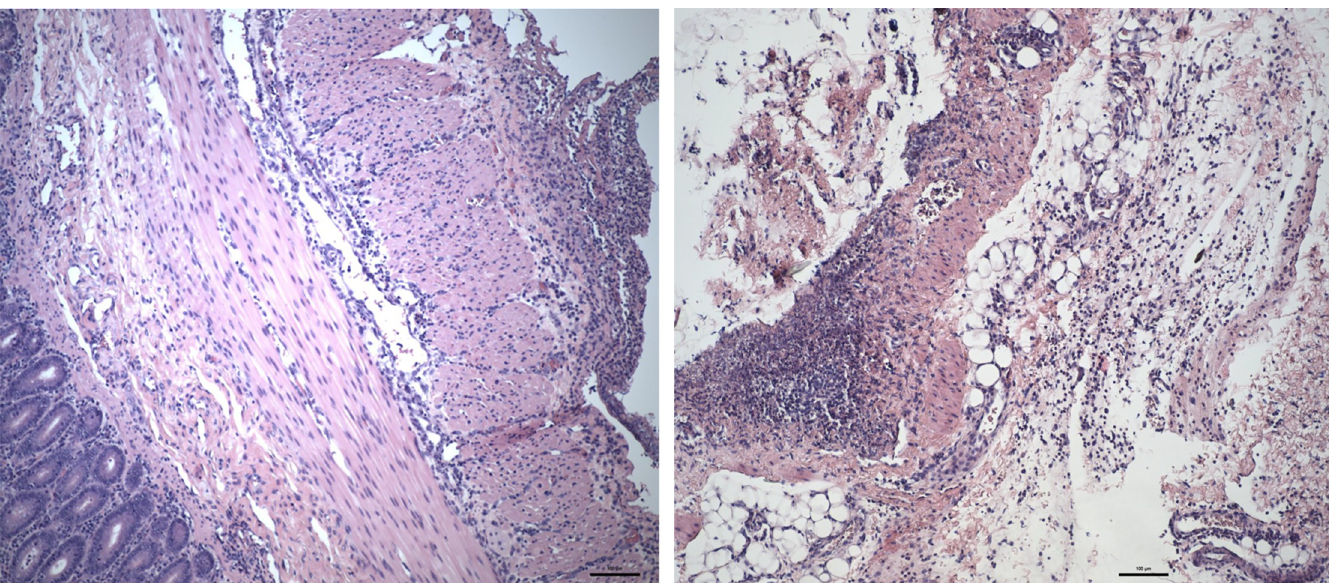
Fig 4. Histology of intestine and mesenterium. 4A The mucosa is down at left and the serosa is at right. The serosa shows a rich fibrinopurulent exudate, consistent with peritonitis. Leukocytes between the smooth muscle layers also are visible (AF-16). 4B Mesenterium. Necrosis and intense inflammatory reaction in the fat and connective tissues, consistent with peritonitis